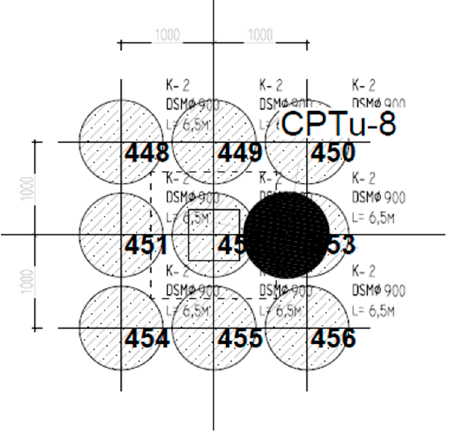
Figure 6. Group No. 1—made based on the representative column No. 454 and the results of the CPTU-8 probing.